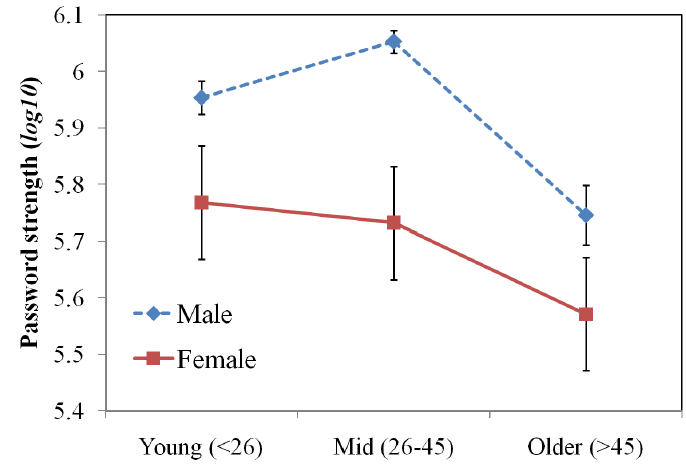
Figure 5. Password strength of different age